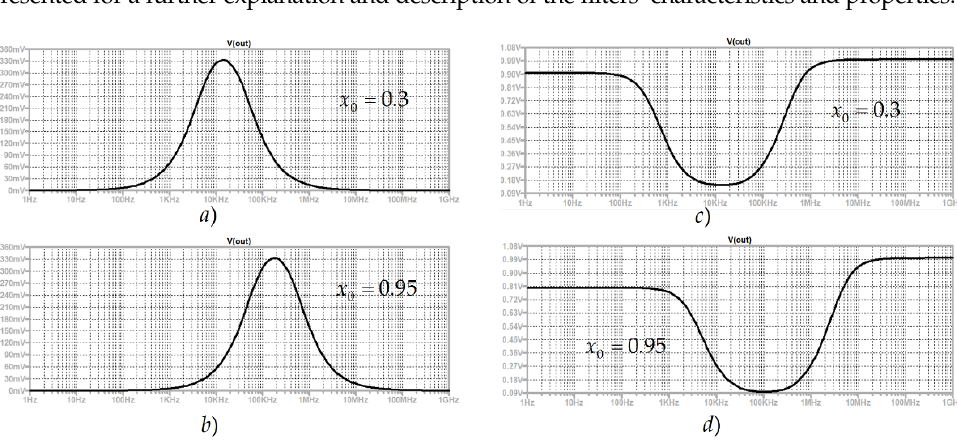
Figure 17. ( a ) Amplitude-frequency response (AFR) of a band-pass filter for x 0 =0.3: ( b ) AFR of a band-pass filter for x 0 =0.95; ( c ) AFR for the band-stop filter for x 0 =0.3; ( d ) AFR for the band-stop filter for x 0 =0.95.